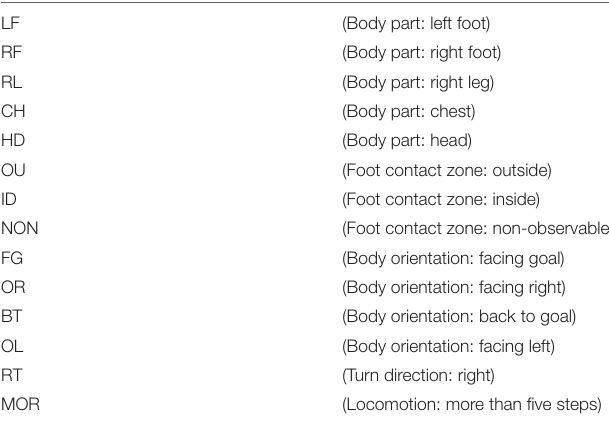
TABLE 2 | Given and conditional behaviors.